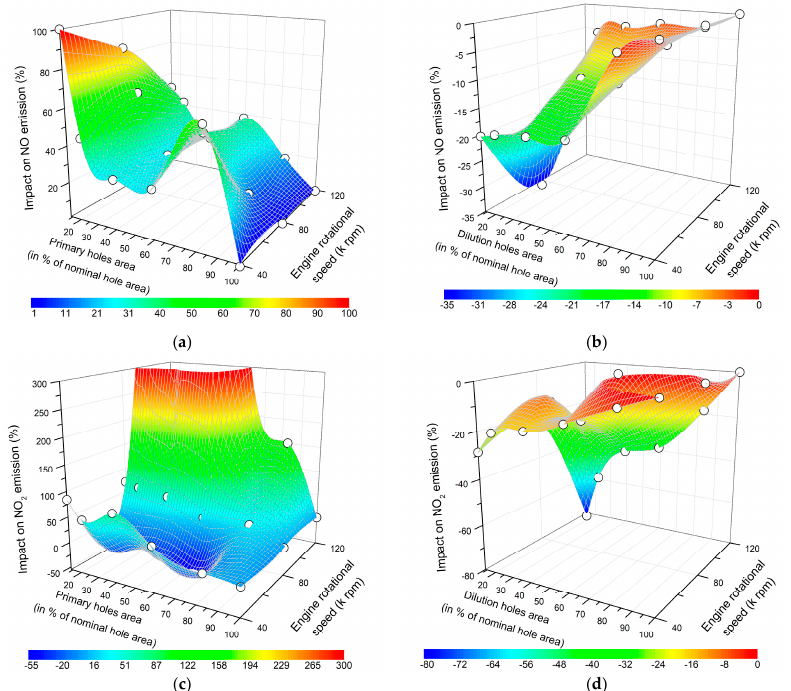
Figure 12. Combustion chamber variable geometry impact on nitrogen monoxide (NO) and nitrogen dioxide (NO 2 ) generation: ( a ) NO and primary hole impact; ( b ) NO and dilution hole impact; ( c ) NO 2 and primary hole impact; ( d ) NO 2 and dilution hole impact.